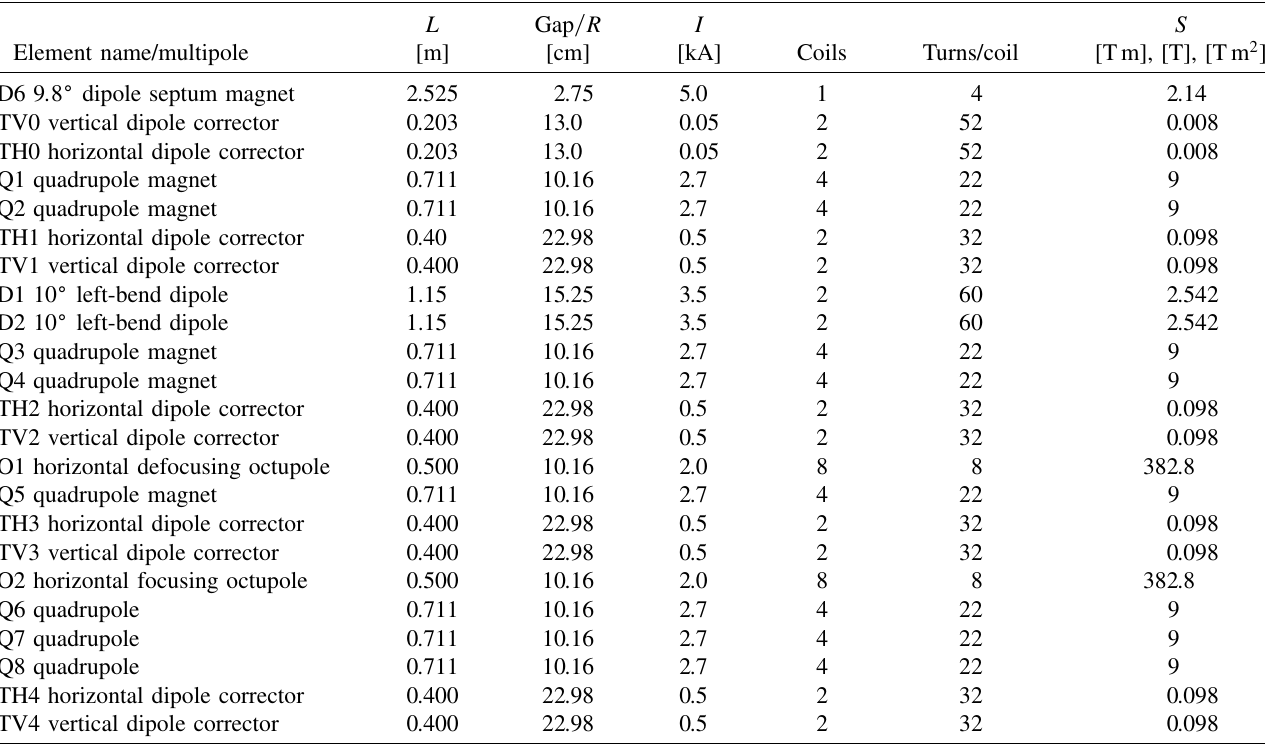
TABLE II. The magnetic elements of the NSRL beam-transport line, and some of their properties. The relative location of the magnetic elements is shown in Fig.